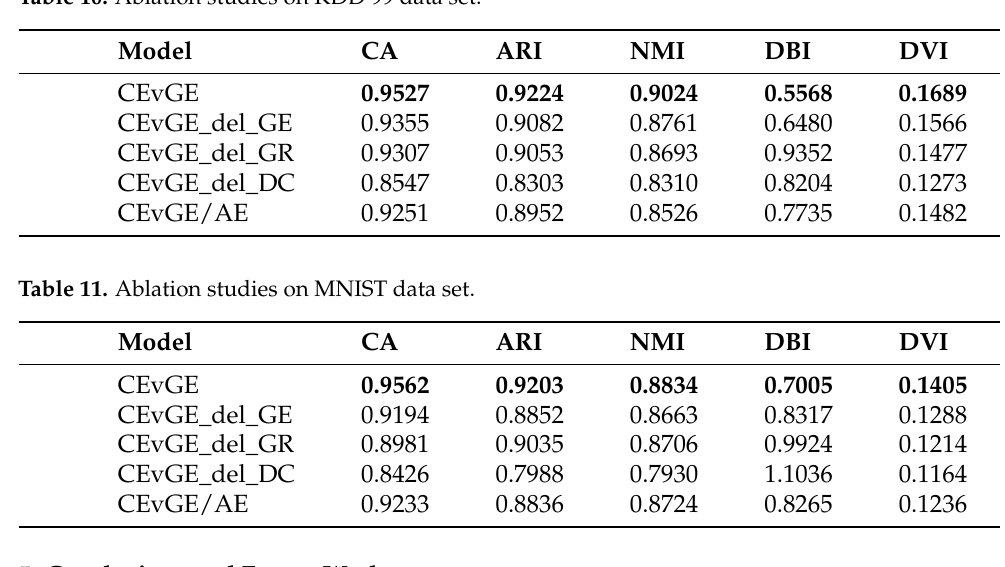
Table 10. Ablation studies on KDD’99 data set.